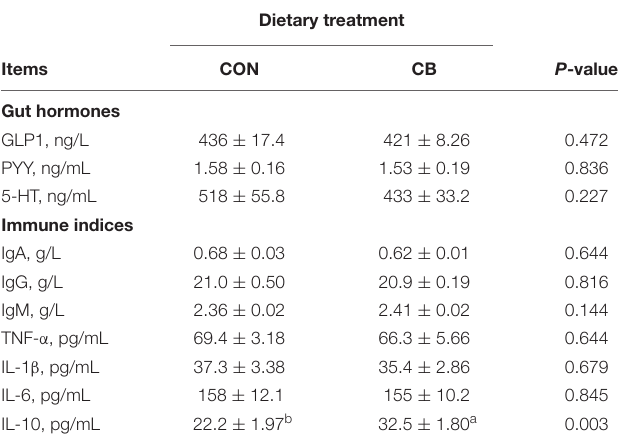
TABLE 3 | The effect of dietary corn bran on indices of gut hormones and immunity in blood plasma of weaned pigs. Dietary treatment